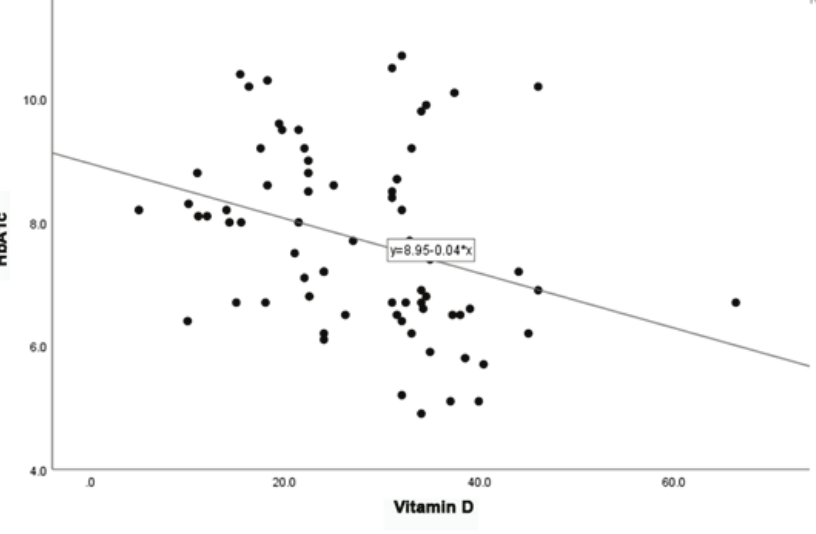
Figure 2. The correlation chart of vitamin D and HbA1c